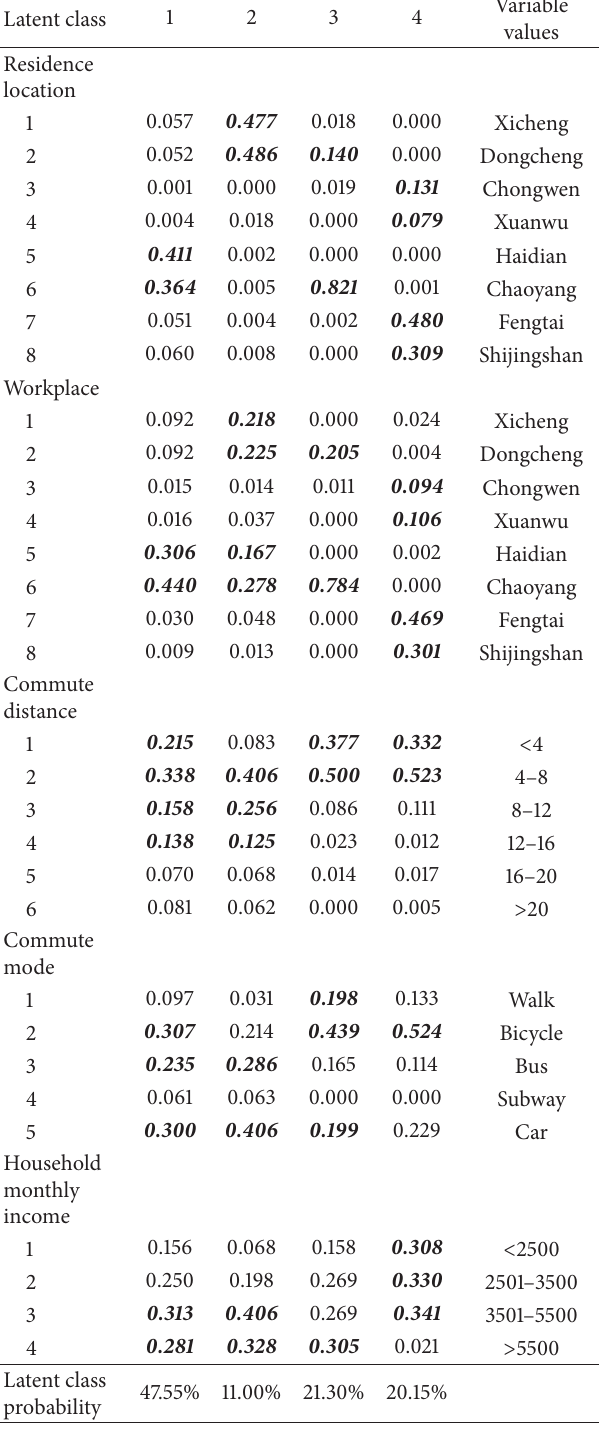
Table 4: Estimation results of the